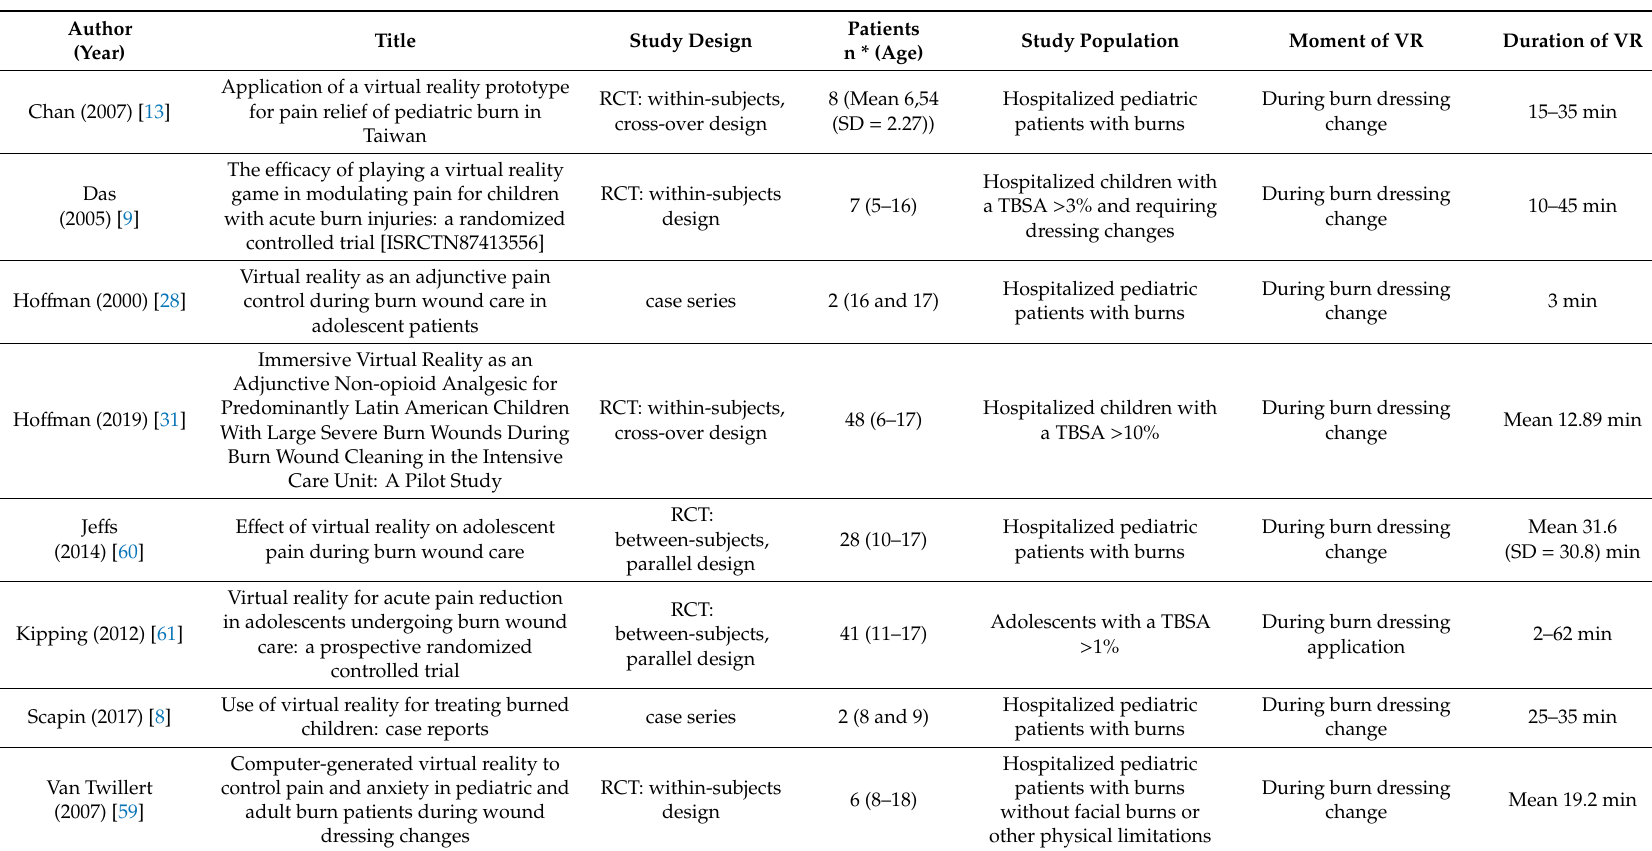
Table A1. Summary of findings for the included